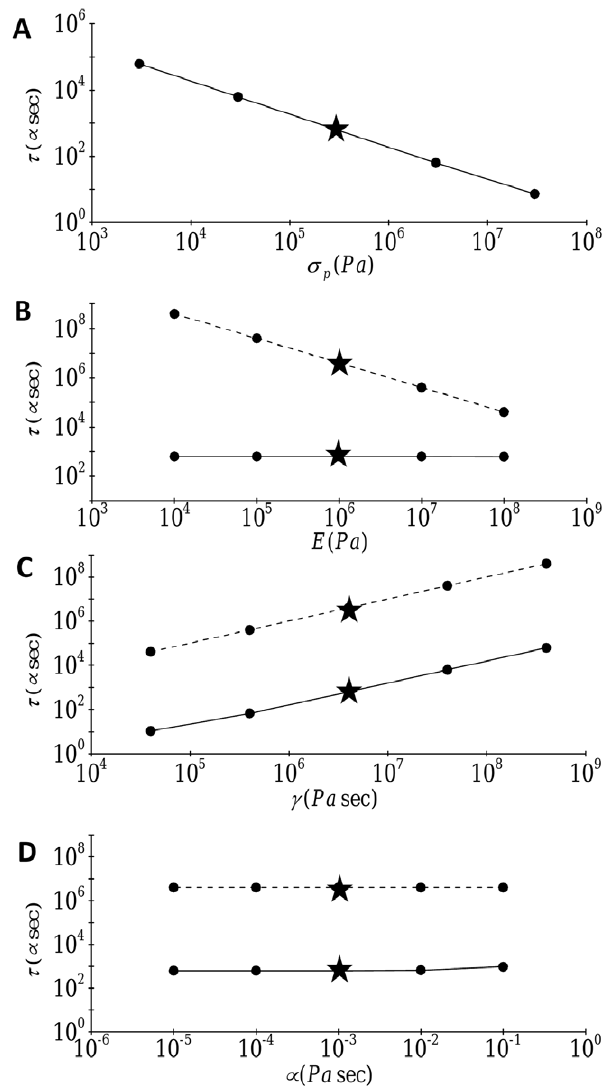
Figure 4. Effect of (A) prestress, (B) elasticity, (C) material viscosity, and (D) cytosolic viscosity on the time constant t for the deformation-related stress evolution at the nucleus ( x ~ L ):––––, transverse motion; width 3.429 pt height 0.5 pt width 3.429 pt height 0.5 pt width 3.429 pt height 0.5 pt width 3.429 pt height 0.5 pt, axial motion. Stars denote the reference values.